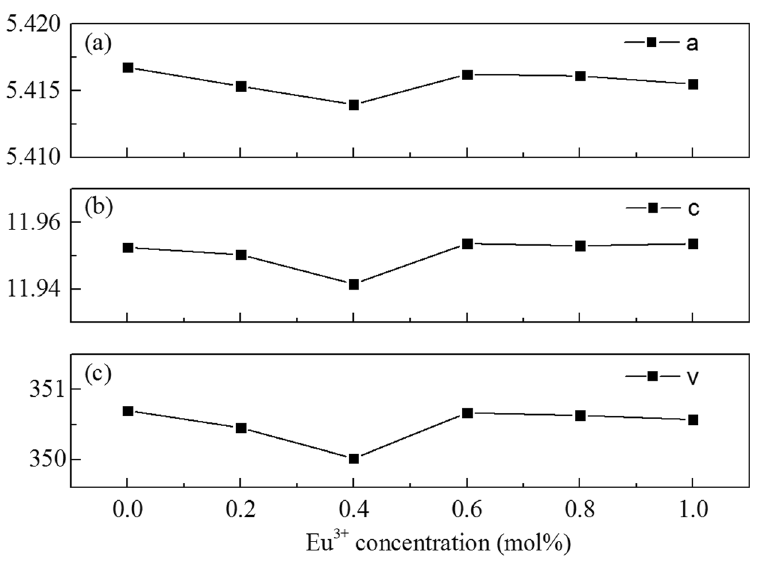
Figure 2. ( a ) Unit cell parameters of a (Å) and ( b ) c (Å) and ( c ) unit cell volume (Å 3 ) at different Eu 3 + concentration in tetragonal SrWO 4 : x Eu 3 + , 4 mol% Dy 3 + ( x = 0, 0.2 mol%, 0.4 mol%, 0.6 mol%, 0.8 mol%, 1